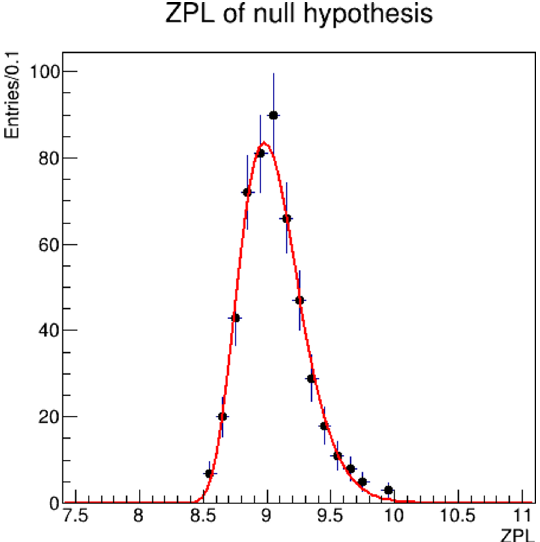
Figure 6 . Distribution of the Z PL test statistic for 500 repetitions of RanBox tests of the null hypothesis in 5000-event background-only samples; a fit to a Gamma function is overlaid. 1000 subspaces are scanned with Algorithm 0 for the box initialization; see the text for more